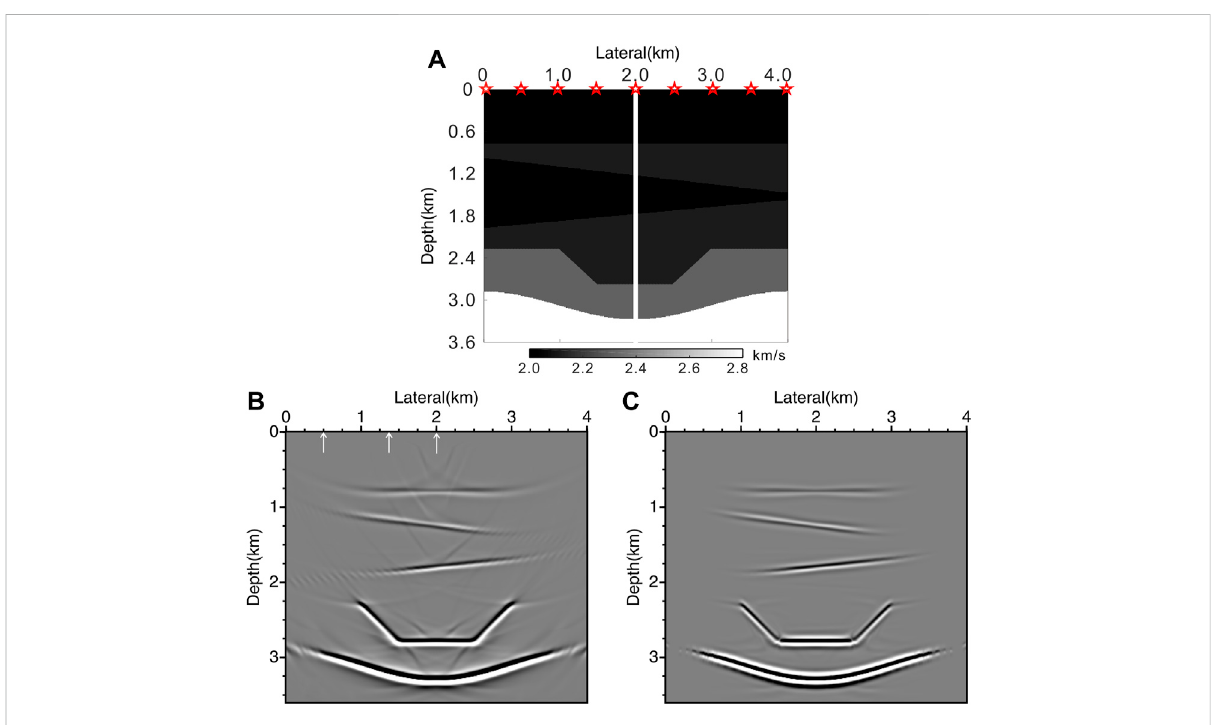
FIGURE 7 Theimagingresultsofthe2Dgrabenmodel. (A – C) arethevelocitymodel,theimagingresultsusingconventionalGRTmigration,andweighted DDGRT migration,